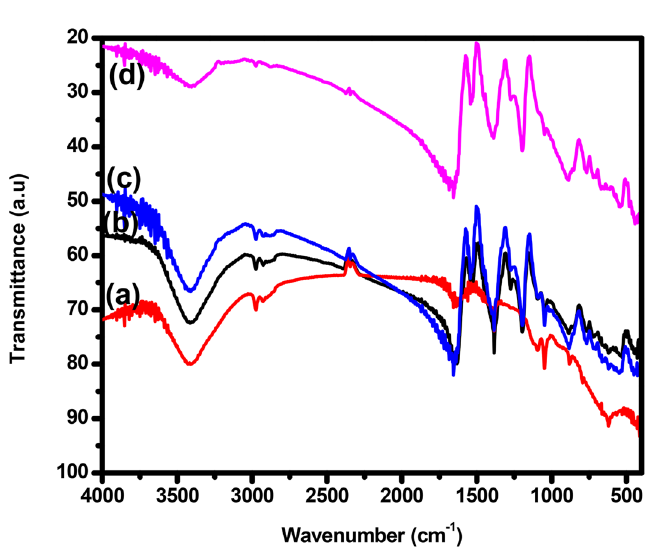
Figure 3. FTIR spectra of (a) Cu 2 O (b) TANI (c) TANI/Cu 2 O and (d) TANI/Cu 2 O/Ag